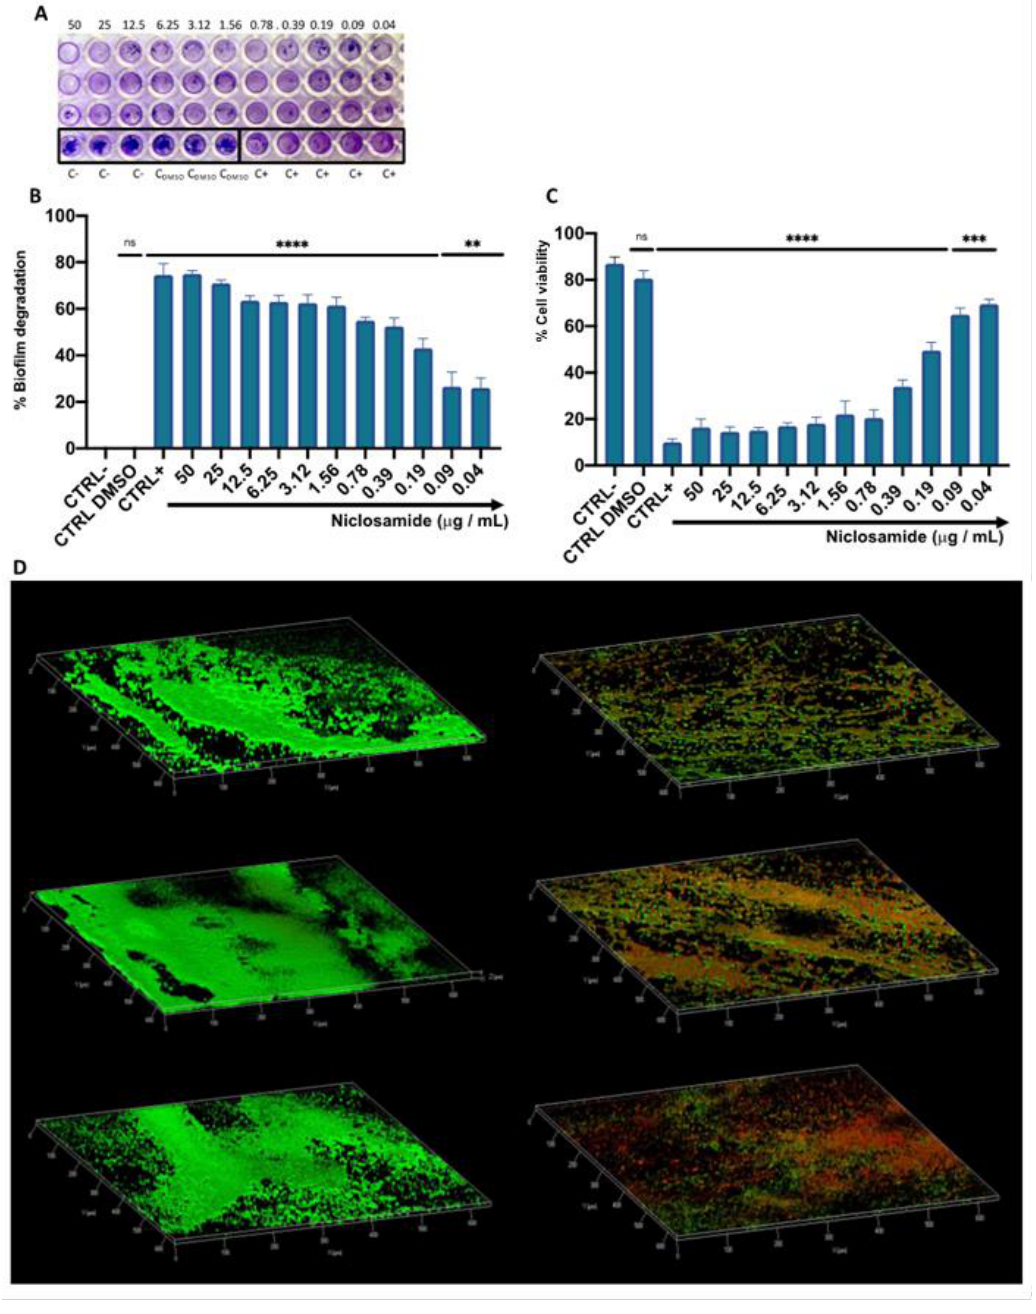
Figure 4. The effect of niclosamide on the preformed biofilm of C. striatum : ( A , B ) degradation of the biofilm matrix quantified by CV-staining; ( C ) Evaluation of the cell viability in the degraded biofilm; CTRL- : untreated biofilm; CTRL+: bacteria treated with vancomycin (20 μg/mL).; CTRL D MSO: bio- film treated with the solvent used to dissolve the drug; The data represent the mean ± SD. Dunnett’s multiple comparisons test: **** p < 0.0001; *** p < 0.0005; ** p < 0.0096; ns p > 0.05. Ordinary one-way ANOVA: p < 0.0001, R 2 = 0.9935; ( D ) confocal images of C. striatum biofilm treated with solvent (left) and niclosamide (right); red indicates dead cells, green points to live cells while yellow/orange is the result of the overlapping of dead and living cells; the images were acquisitions from three “ ran- domly selected ”